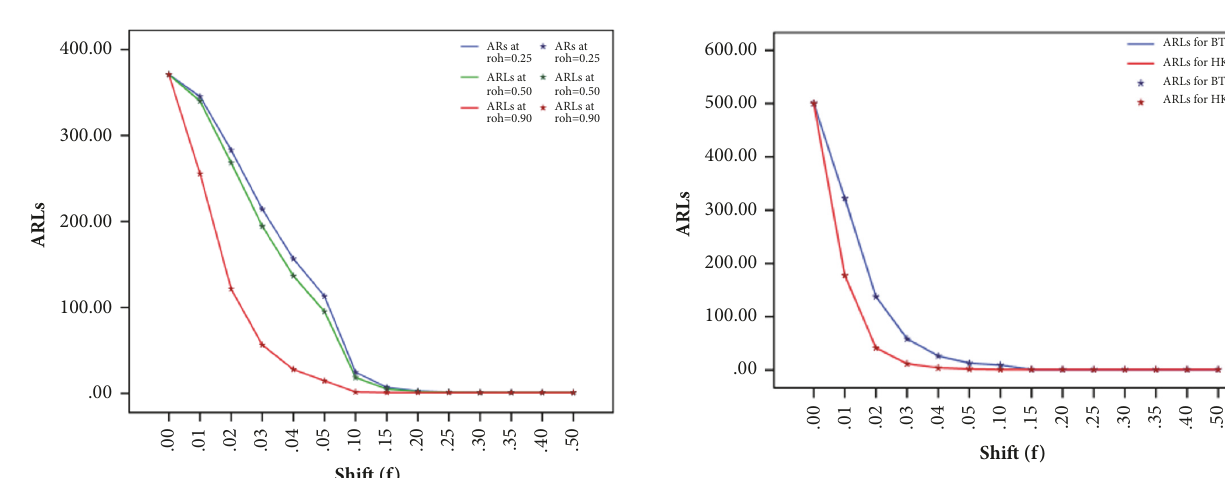
Figure 15: ARLs for proposed repetitive EWMA-RSS control charts using ratio estimators, for 𝜌 = 0.90 when 𝑟 𝑜 = 500 at 𝜆 = 0.1.